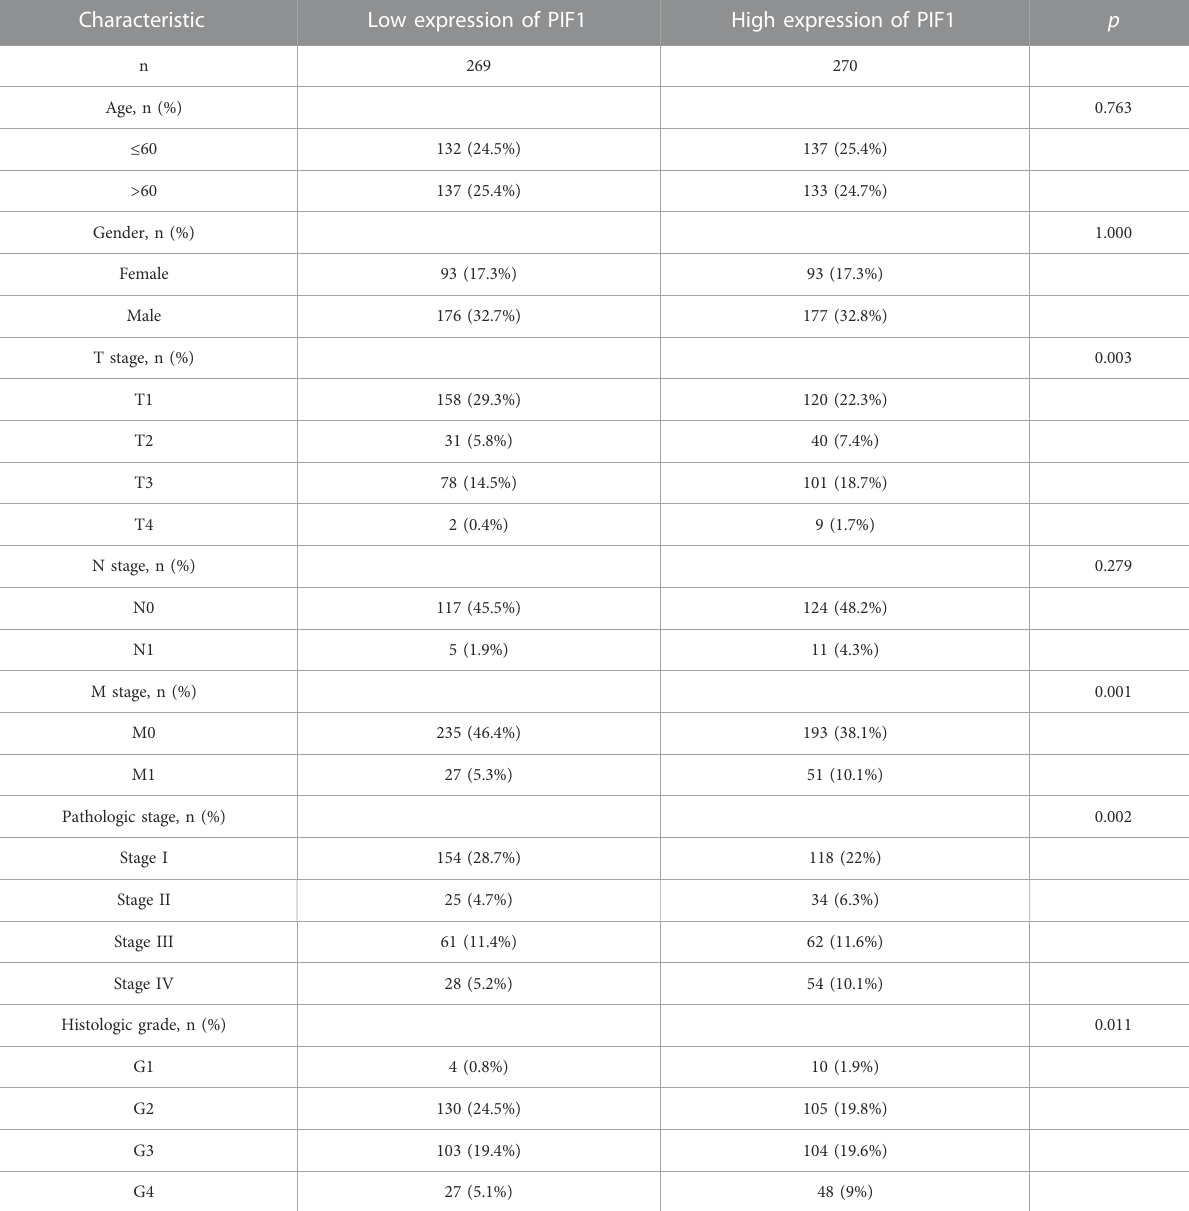
TABLE 1 The clinical characteristics of ccRCC patients between the high PIF1 expression group and low expression group.